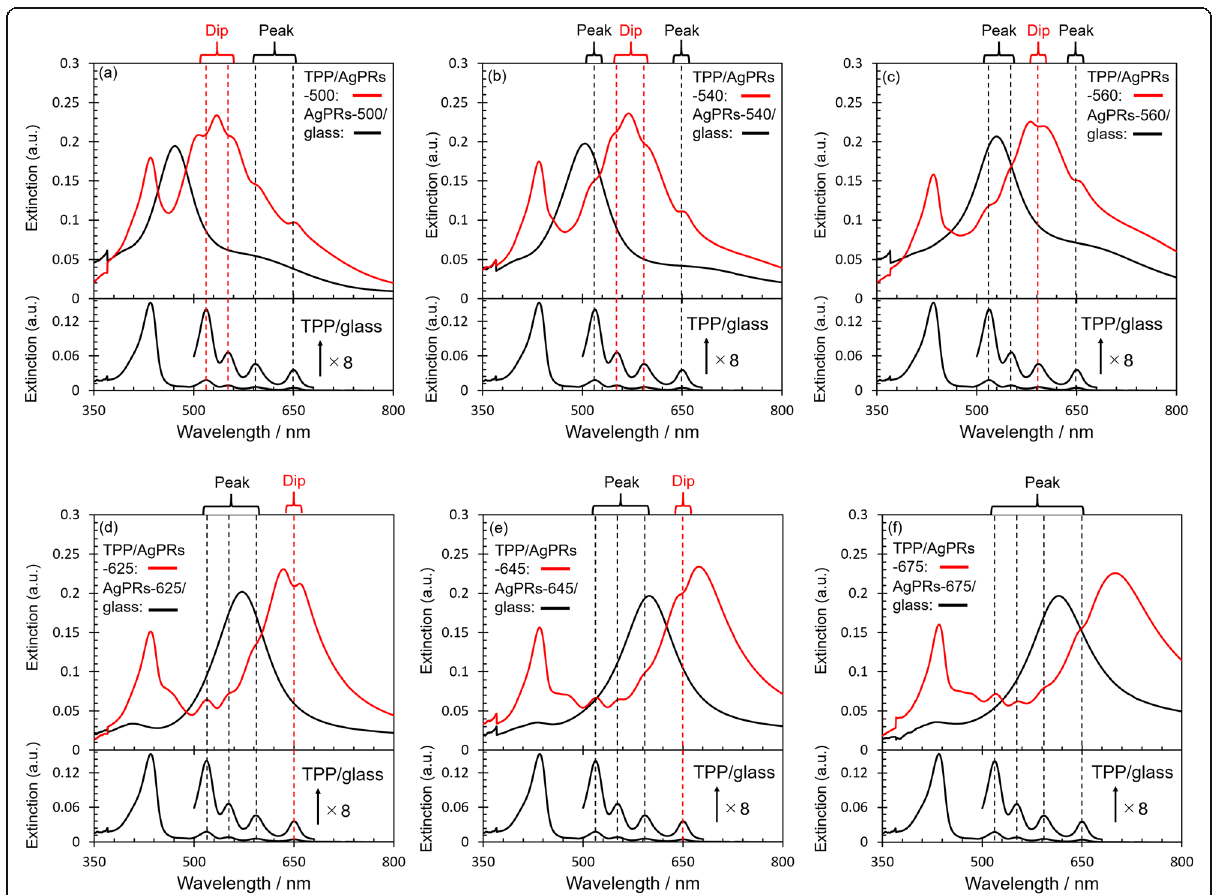
Fig. 3 Extinction spectra. Dashed lines on the spectra represent absorption peak wavelengths of Q-bands of TPP/glass. a AgPRs-500/glass. b AgPRs-540/glass. c AgPRs-560/glass. d AgPRs-625/glass. e AgPRs-645/glass. f